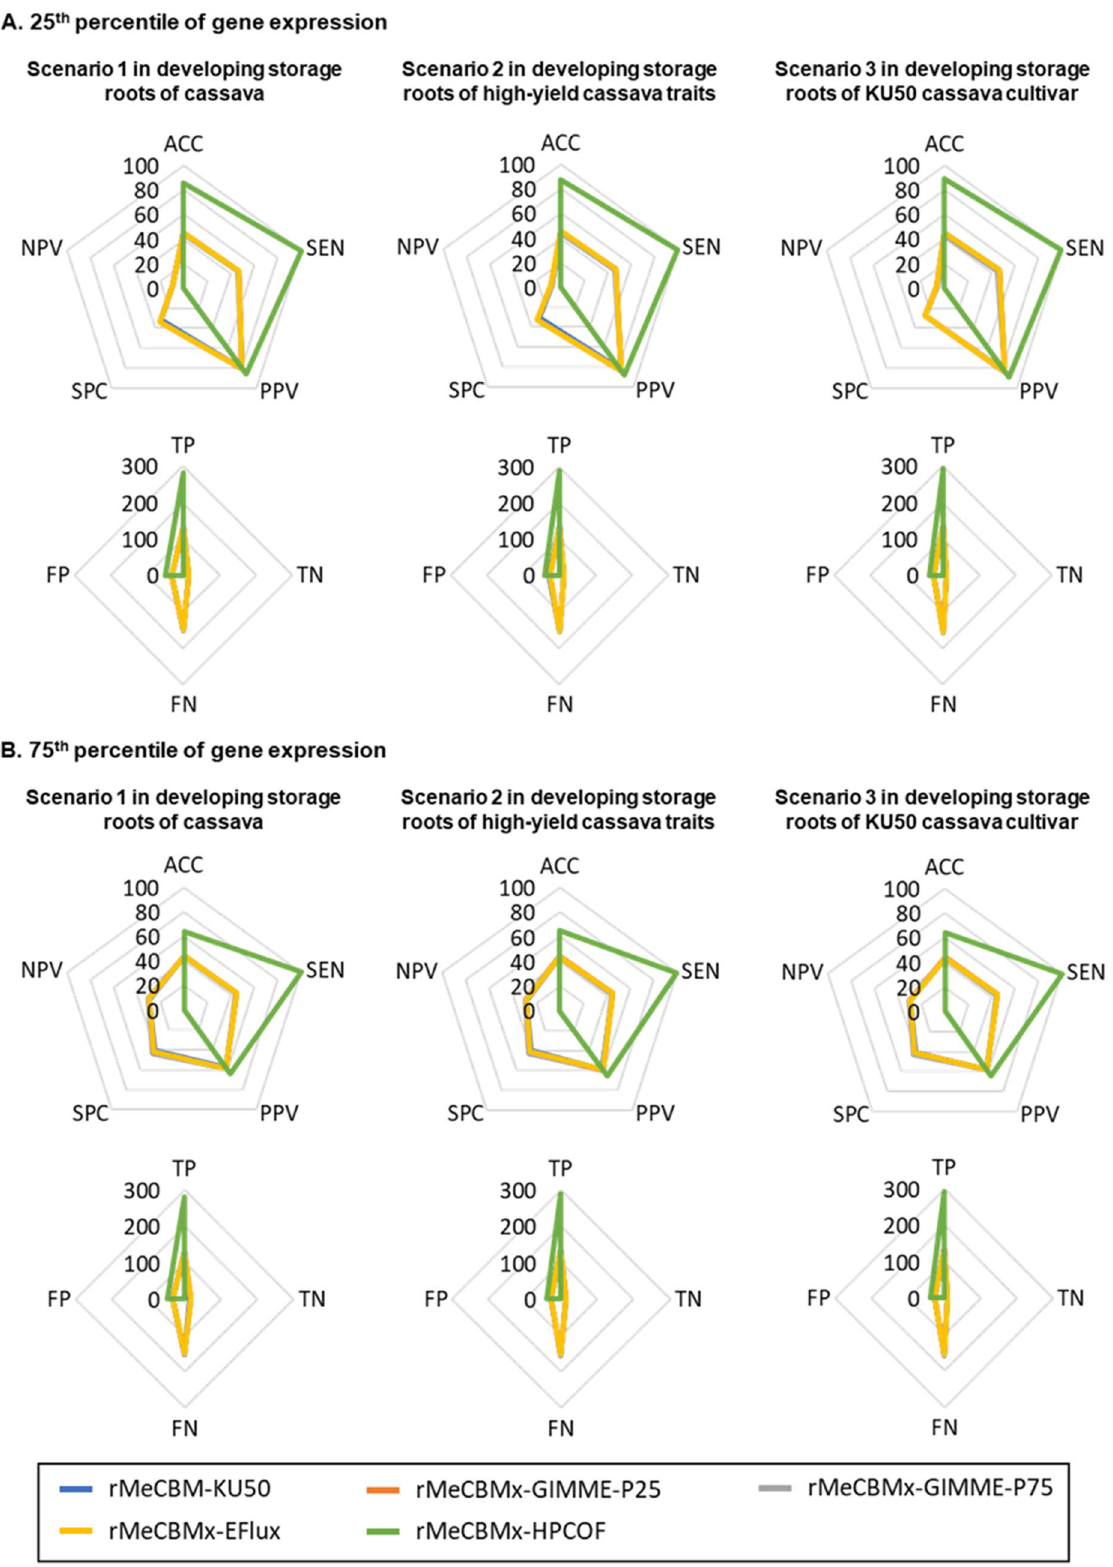
Figure 4. The qualitative analysis of model performance based on three algorithms at varied thresholds of expressed genes from transcriptome data (see more details in Supplementary Fig.